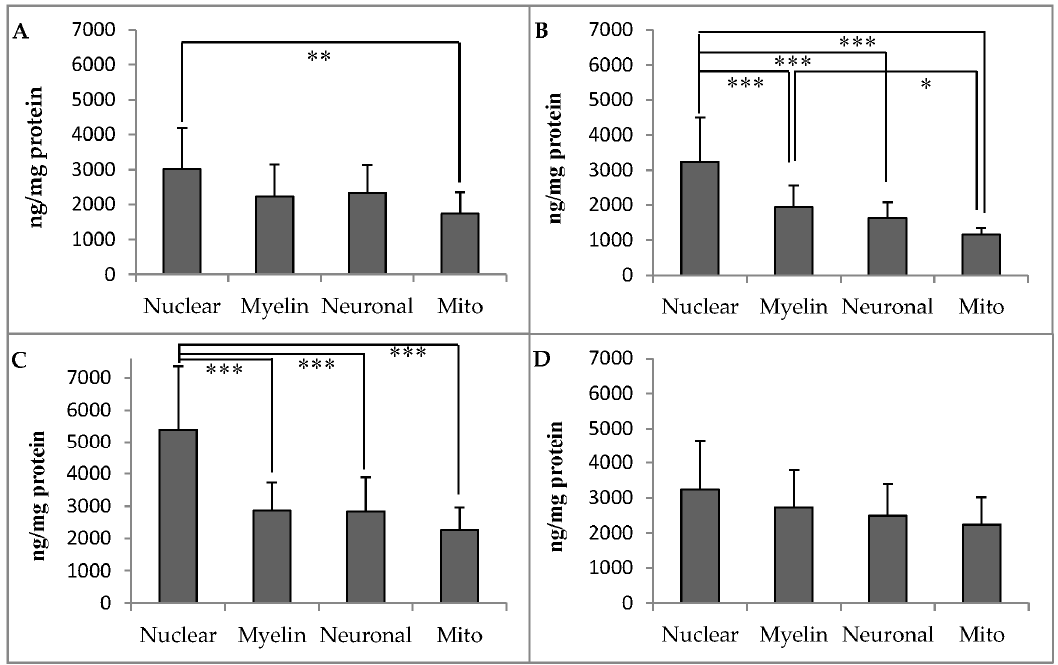
Figure 2. Membrane α -tocopherol concentrations (ng/mg protein, mean ± SD) in the ( A ) prefrontal cortex; ( B ) cerebellum; ( C ) striatum; and ( D ) hippocampus of adult rhesus macaques ( n = 9). Asterisks indicate significant differences between brain regions according to one-way analysis of variance (ANOVA) followed by Tukey’s honest significant difference (HSD) test; * p < 0.05, ** p < 0.01, *** p < 0.001. Nuclear: nuclear membrane; myelin: myelin membranes; Neuronal: neuronal plasma membrane; Mito: mitochondrial membranes.